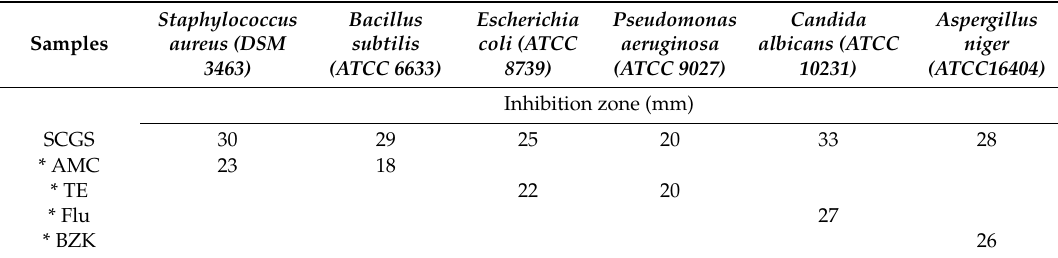
Table 1. The antimicrobial activity of the synthesized cationic gemini surfactant (SCGS). The result was described as a mean of the inhibition zones diameter (mm).